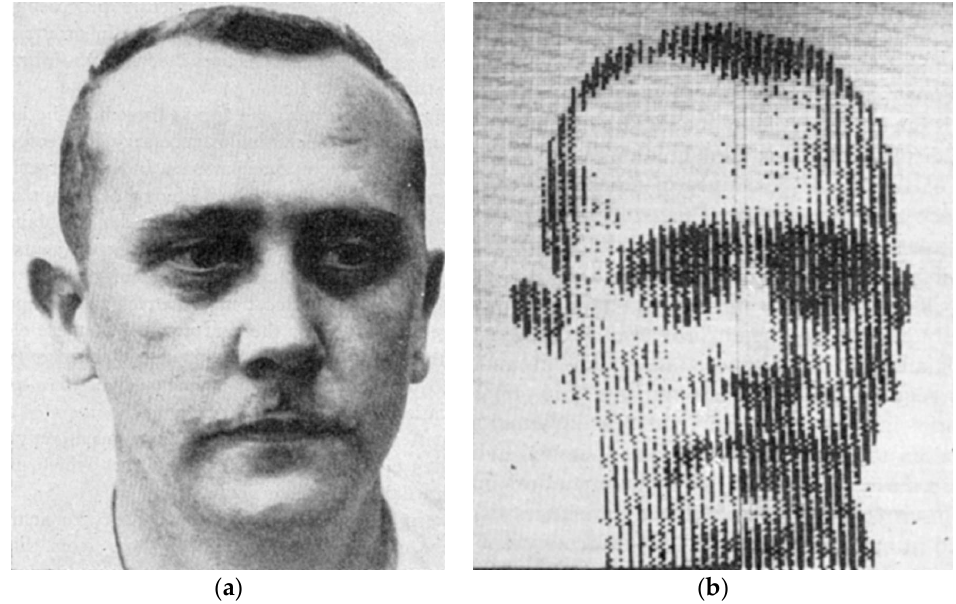
Figure 1. The Russell A. Kirsch’s photograph: ( a ) The original one; ( b ) The image after the scanning